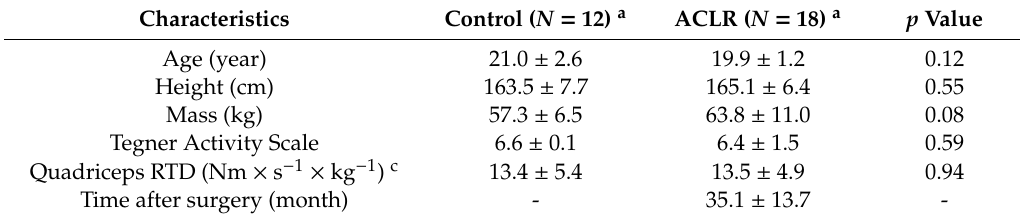
Table 1. Participant Demographics and Group